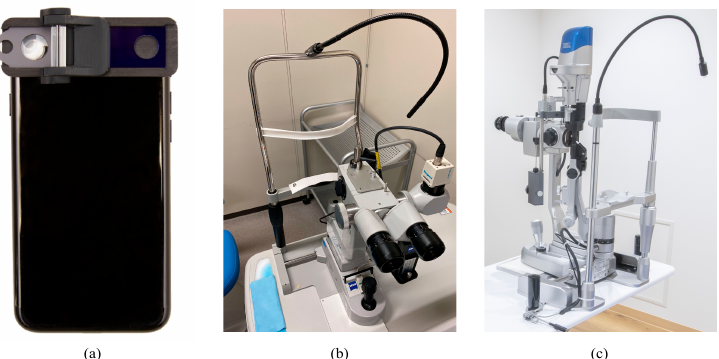
Figure 2. Photographs of the SEC and the conventional slit-lamp microscopes. ( a ) The SEC, ( b ) SL130, and ( c ) 700GL.